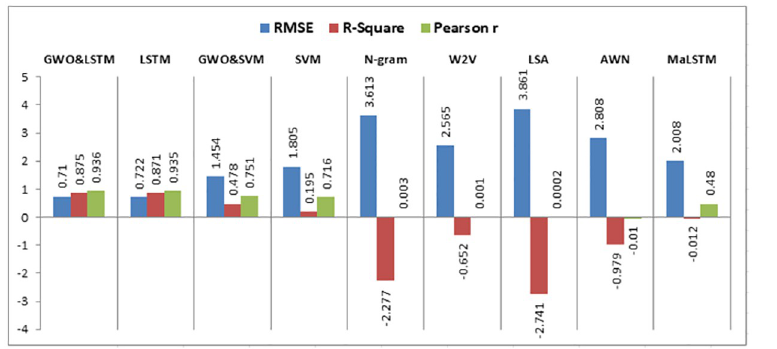
Fig 27. LSTM-GWO performance evaluation with experiment 5.